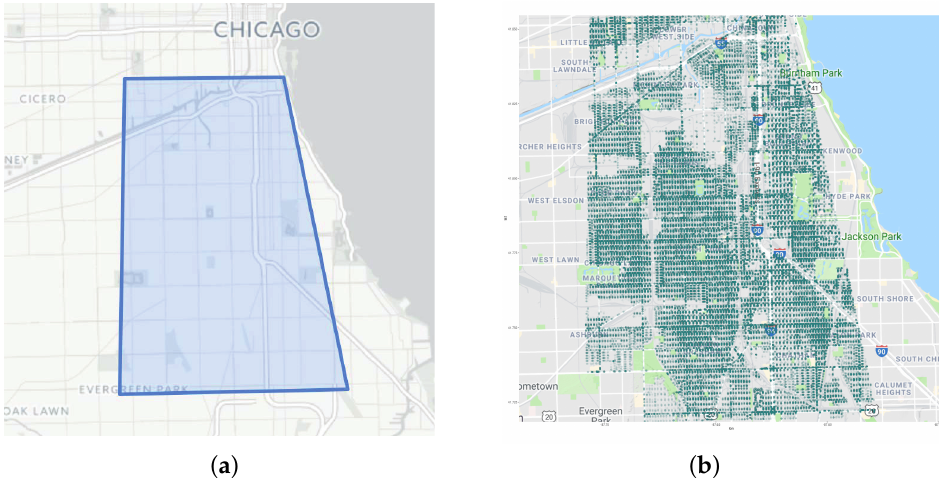
Figure 10. Selected area of Chicago and geo-localized crime events. ( a ) Polygon of the area; ( b ) geo- localized crime events.